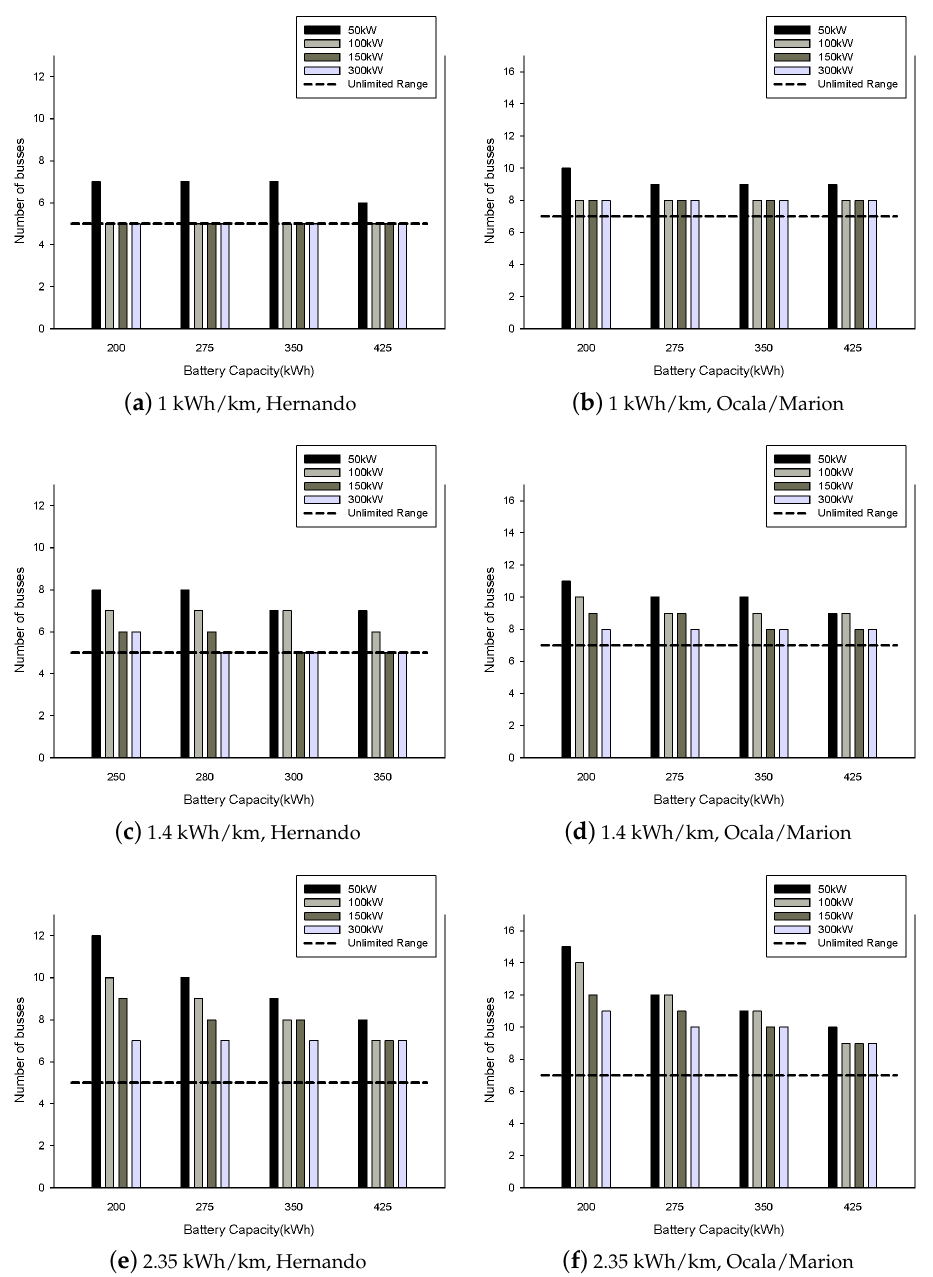
Figure 5. Number of EBs with different ranges dependent on depot charging power to achieve a small public bus transport system. In each of the subfigures the dashed line corresponds to the number of DBs needed for the same